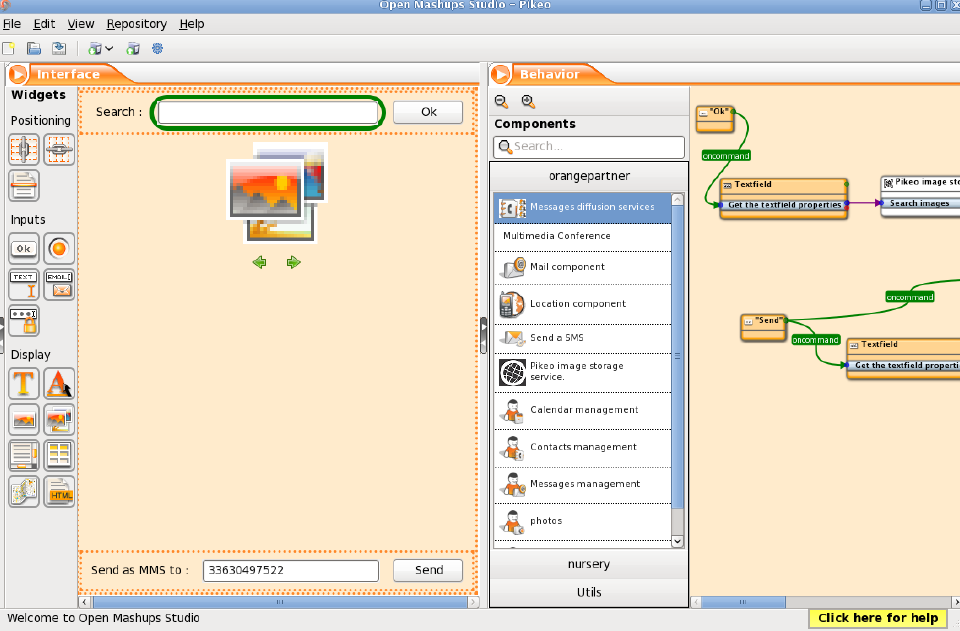
Figure 11. Open Mashups Studio